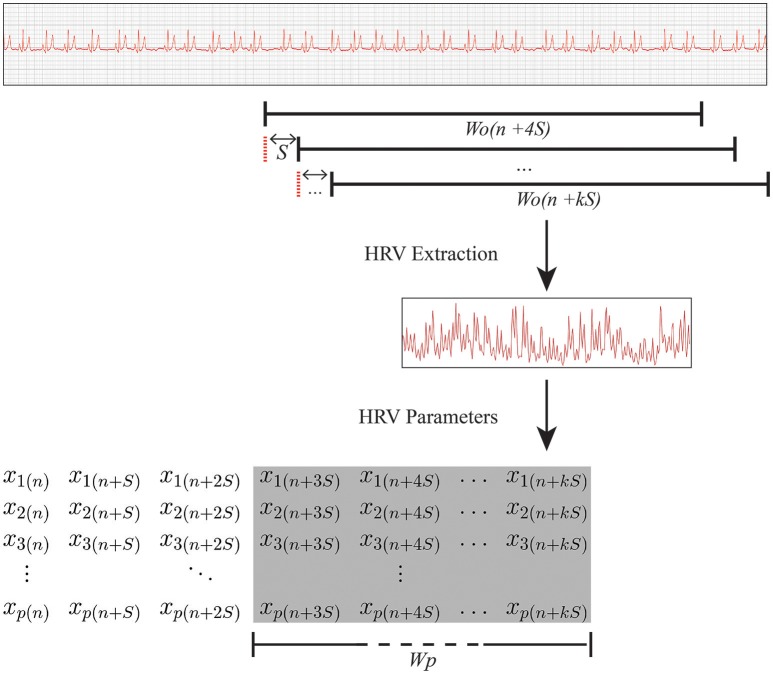
Relationship between Wo and Wp. RR interval data were extracted from multiple overlapping observation windows of Wo seconds in the ECG recording. Subsequently, a set of HRV parameters was calculated and inserted into prediction matrix X (which is shown in the shaded area of the overall matrix), with duration Wp (i.e., the duration of the period analyzed by the classifier). k, the last step of the overlapping observation window slide in a ECG sample; S, step, in seconds, that is the overlapping observation window slides through between the current extraction period and the start of the next one; Wo, observation window, in seconds, the length of the ECG segment used to extract the HRV parameters; Wp, prediction window, in seconds, the duration of the period analyzed by the classifier; xp(n), the pth parameter extracted in the nth sample.